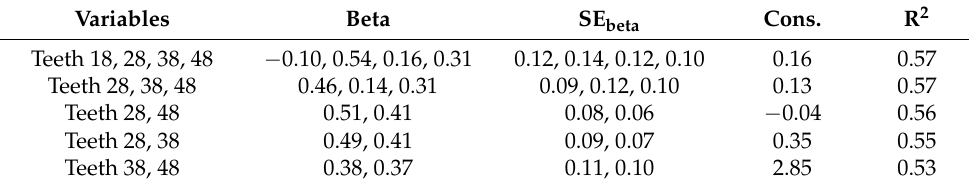
Table 3. Linear prediction of age when utilizing mineralization of several teeth